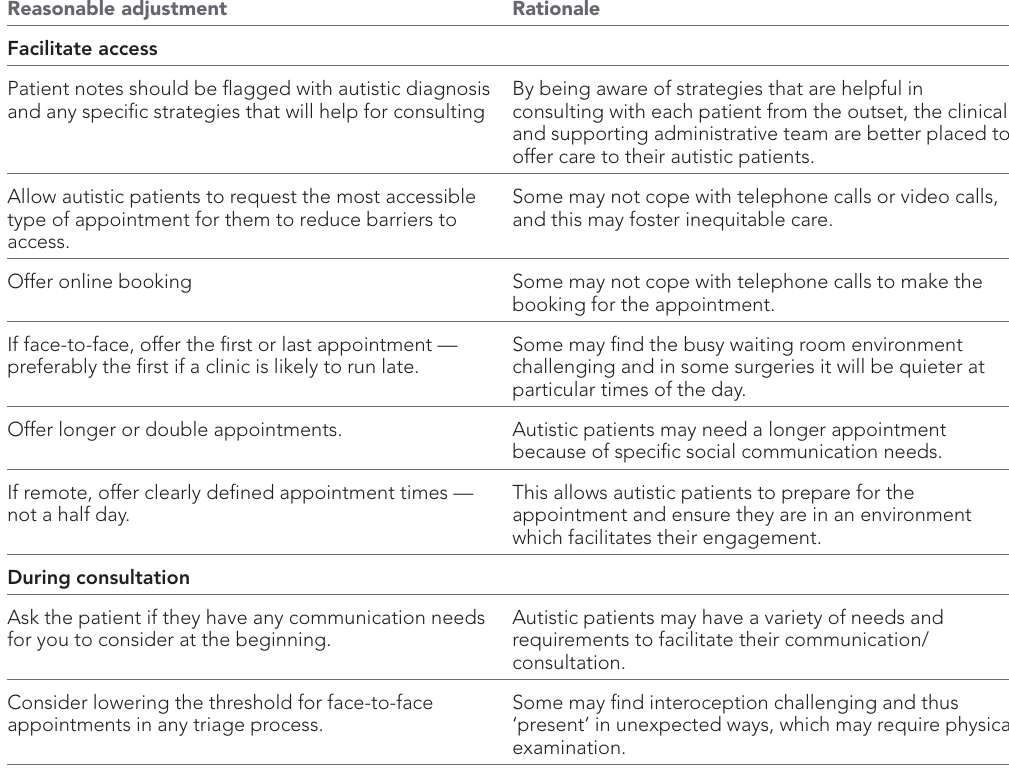
Table 1 Our recommendations for autistic patients Reasonable adjustment